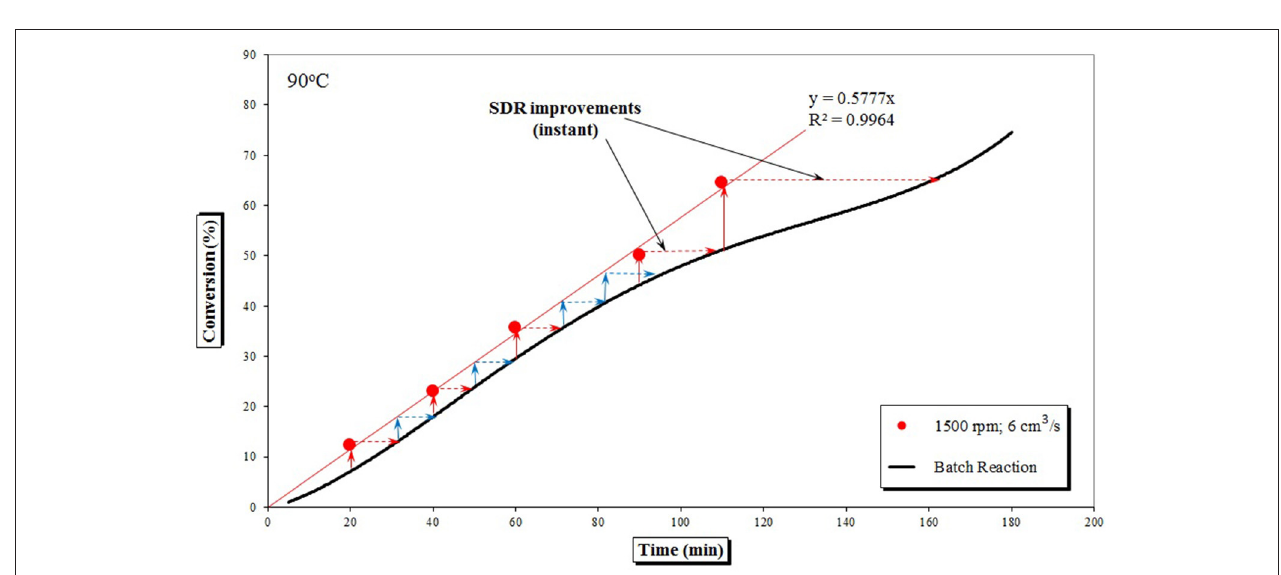
FIGURE 4 | Comparison of SDR and batch reactor conversion profiles (reaction time savings).